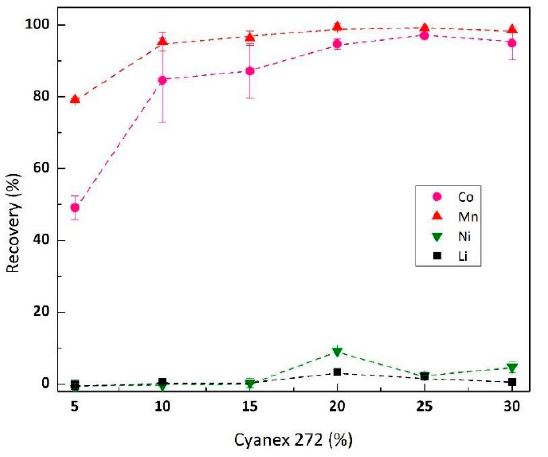
Figure 4. Effect of Cyanex ® 272 concentration ( v/v ) on Co-Mn co-extraction from raffinate (pH 5, metal concentration in feed Co 3.3 g/L, Mn 0.16 g/L, Ni 0.14 g/L and Li 0.62 g/L).